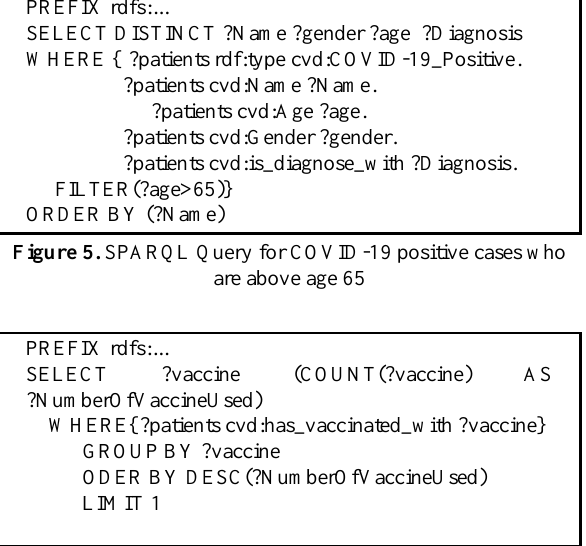
Figure. 6. SPARQL query for vaccine jab the